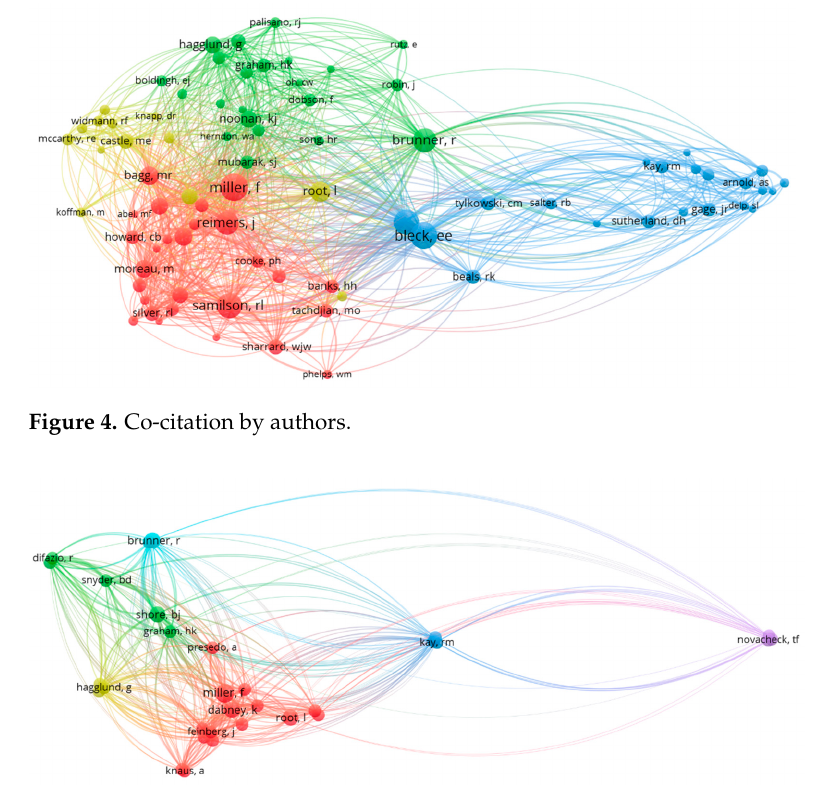
Figure 5. Bibliographic coupling by authors.